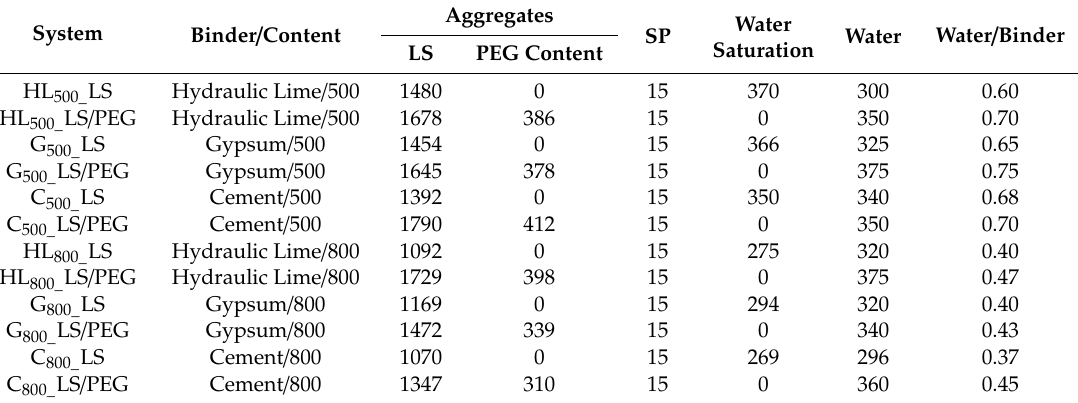
Table 1. Mortar compositions (reported as kg / m 3 of produced